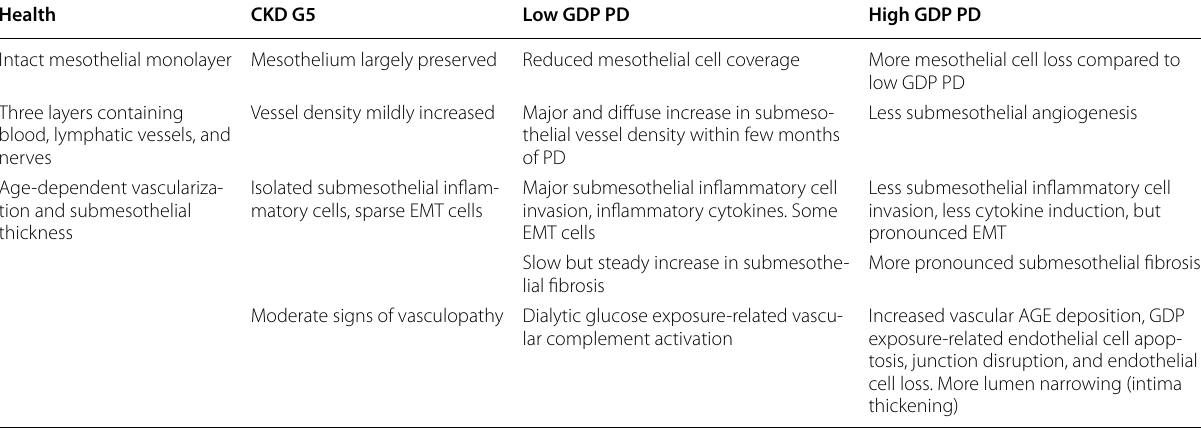
Table 1 Overview on peritoneal histomorphology in children with normal renal function and chronic kidney disease grade 5 and in children on peritoneal dialysis (PD) with PD fluids containing low and high concentrations of glucose degradation products (GDP). EMT epithelial-to-mesenchymal